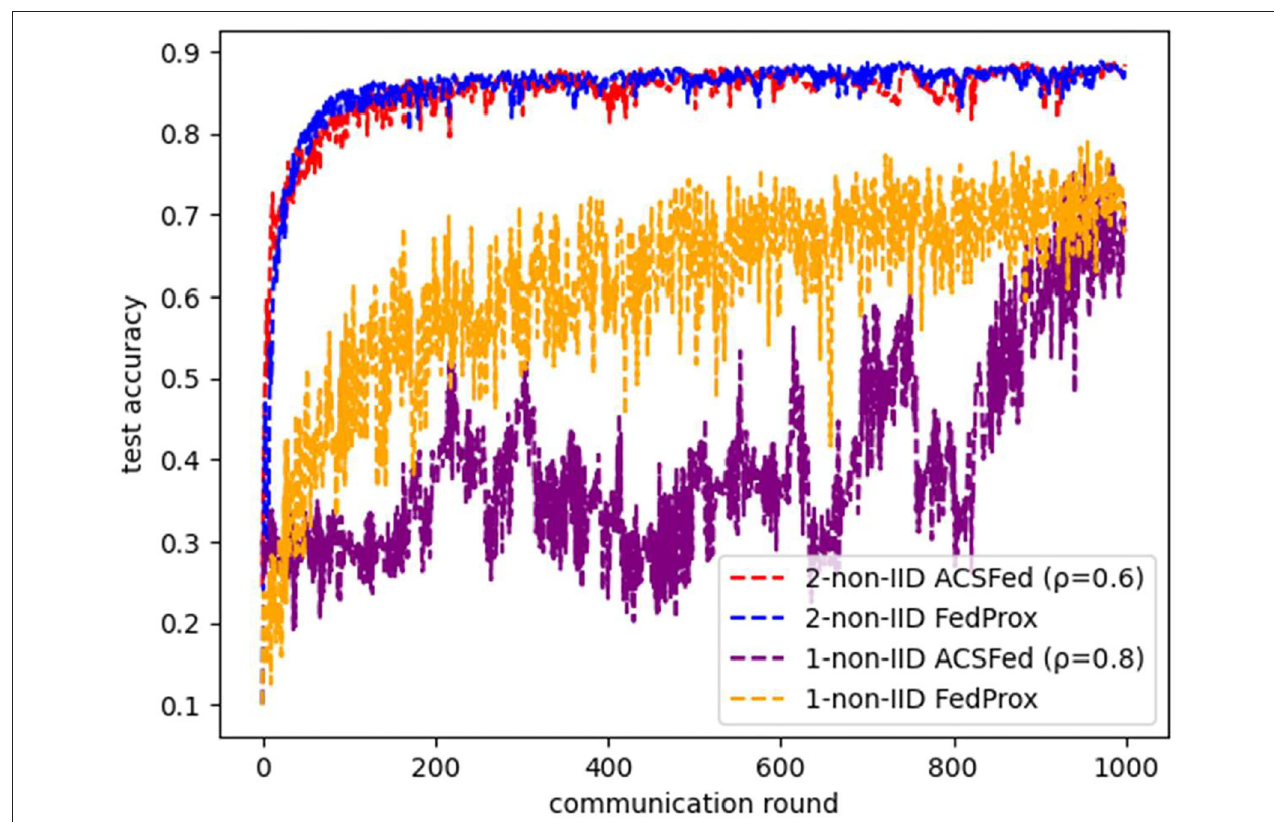
FIGURE 10 | Comparison results between ACSFed and FedProx on fashion